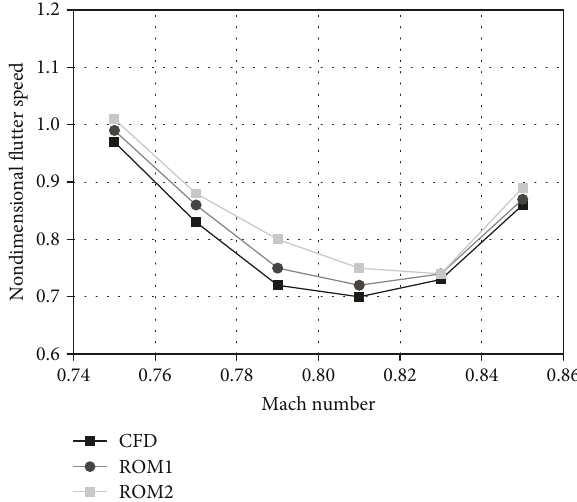
Figure 17: The fl utter boundary of the airfoil with the mean angle of = 3 deg (ROM1-training data via CFD; ROM2-training attack α 0 data via the proposed